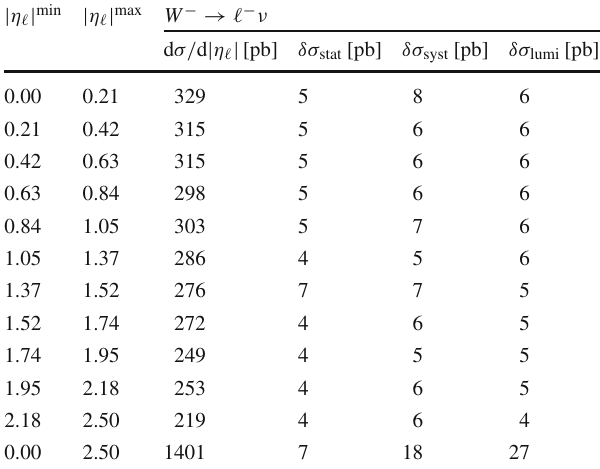
Table 7 Combined fiducial W − → (cid:5) − ν differential and integrated cross sections